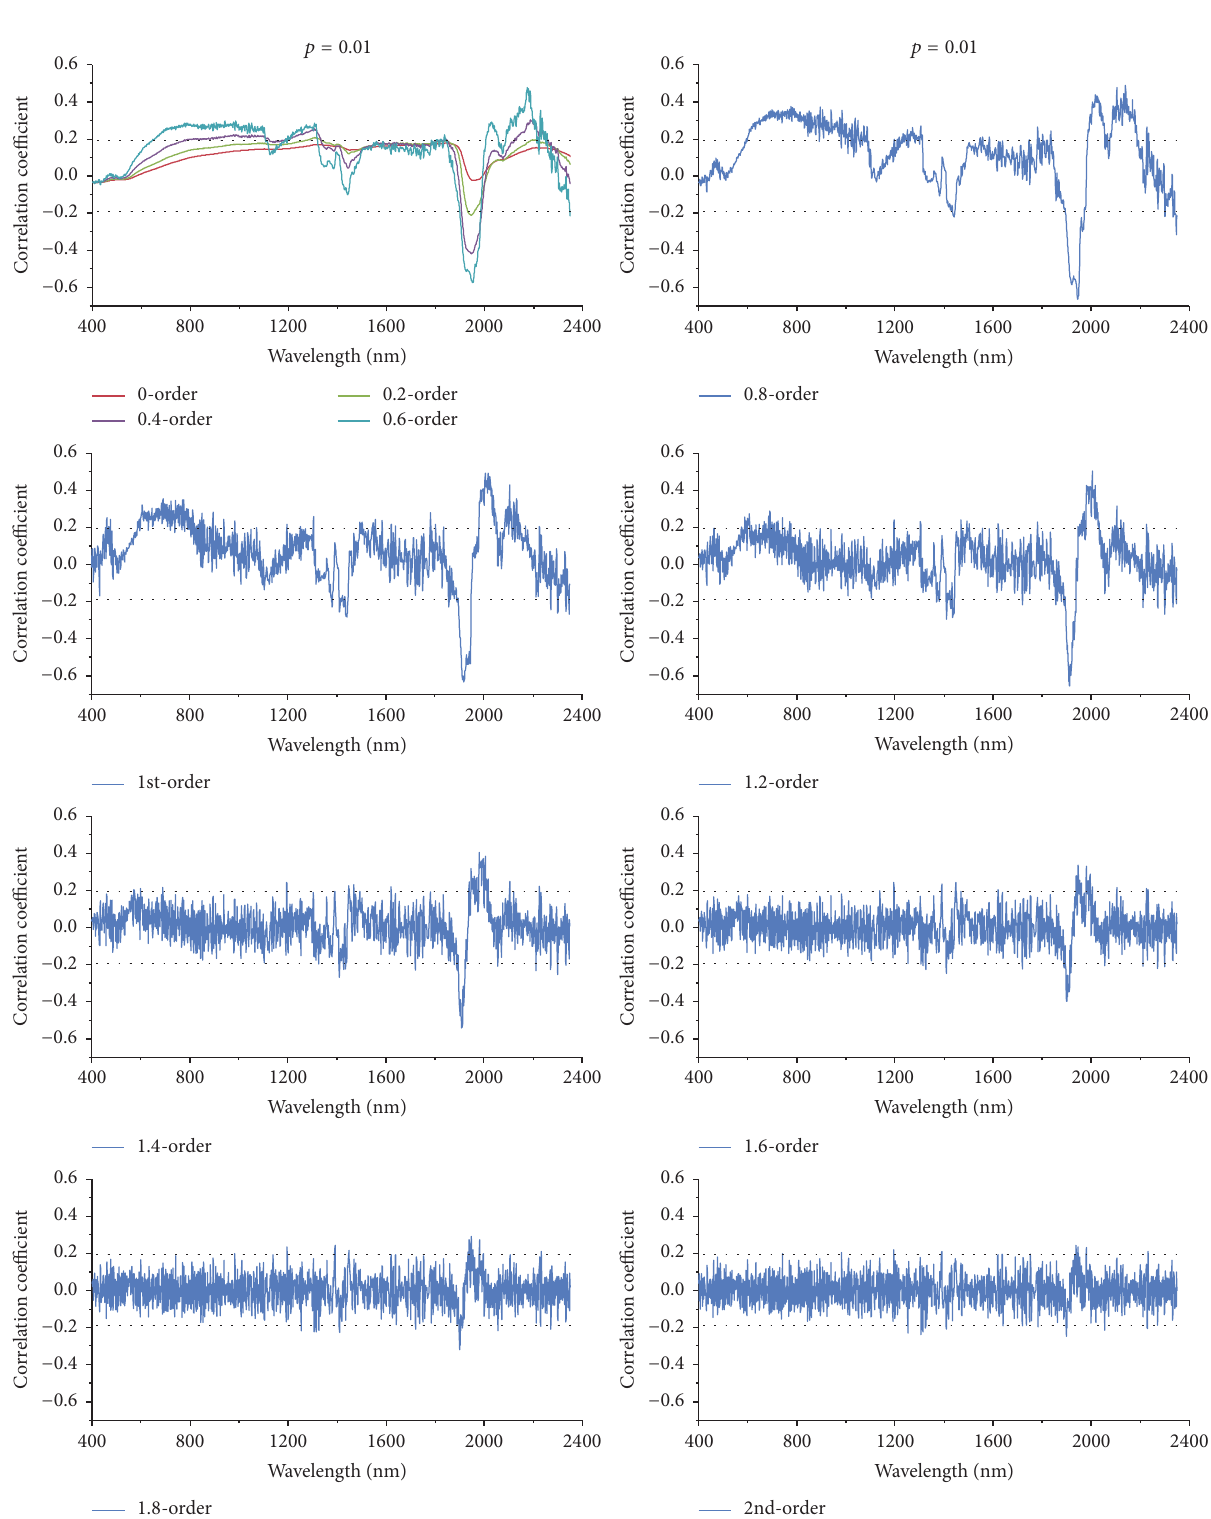
Figure 4: Correlation coefficients between salt content and raw reflectance data treated by fractional